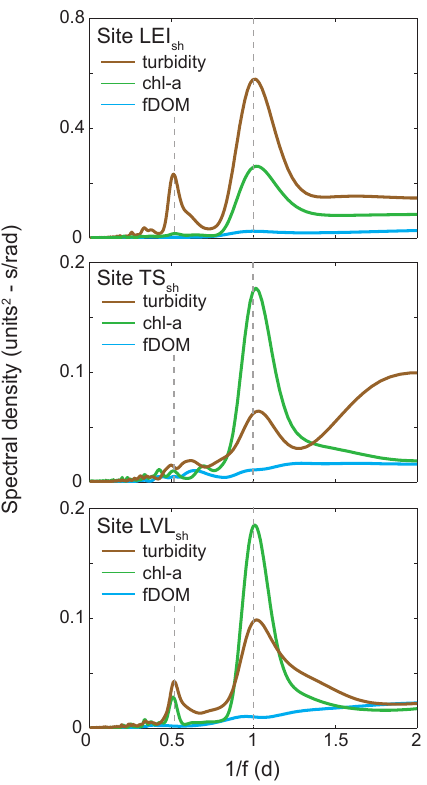
Figure 4. Spectral density of turbidity, chlorophyll a , and fDOM time series from three shoal sites. Dashed lines correspond to M 2 tidal period (0.5175d) and the diurnal period (1d). Note the dif- ference in y axis scaling at LEI sh in comparison to the other two